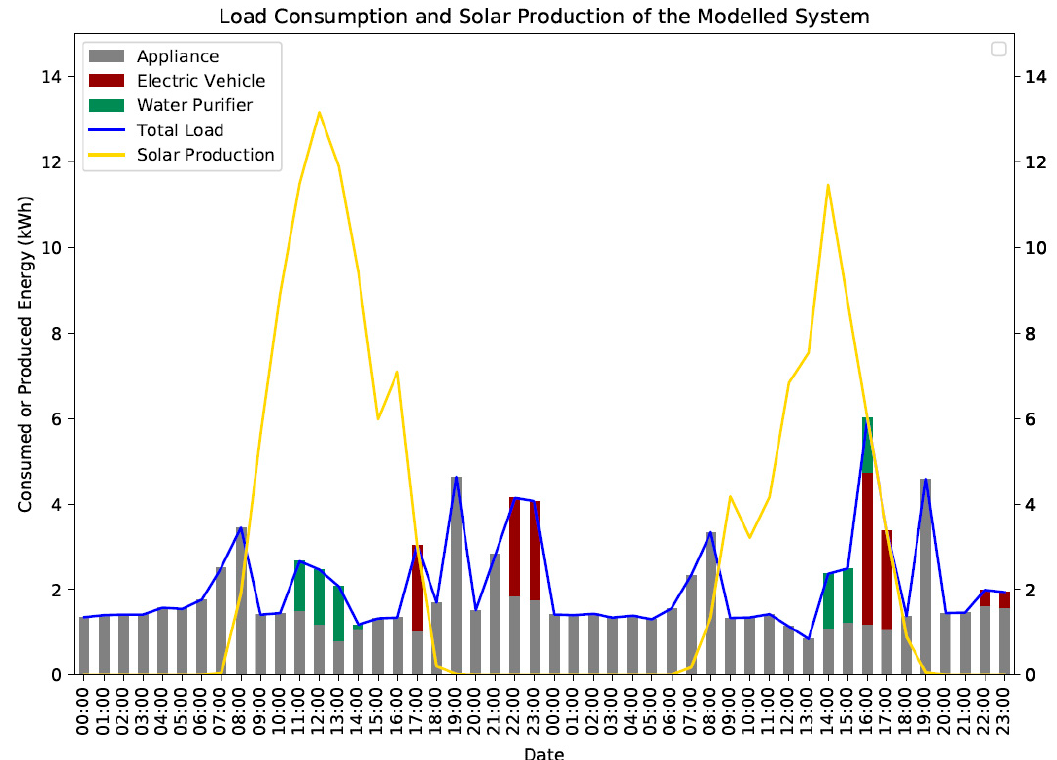
Figure 4. Energy production and load trend modelled system.